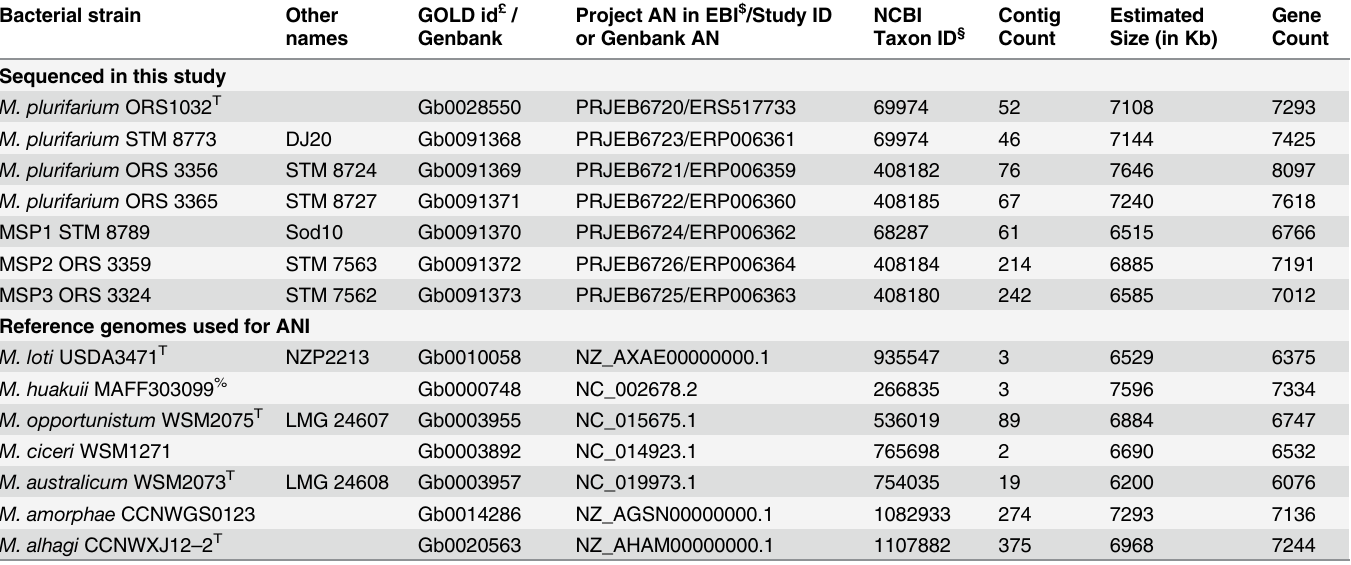
Table 3. Genome characteristics of strains sequenced as part of this study as well as reference genomes used for average nucleotide identities calculations (ANI). Bacterial